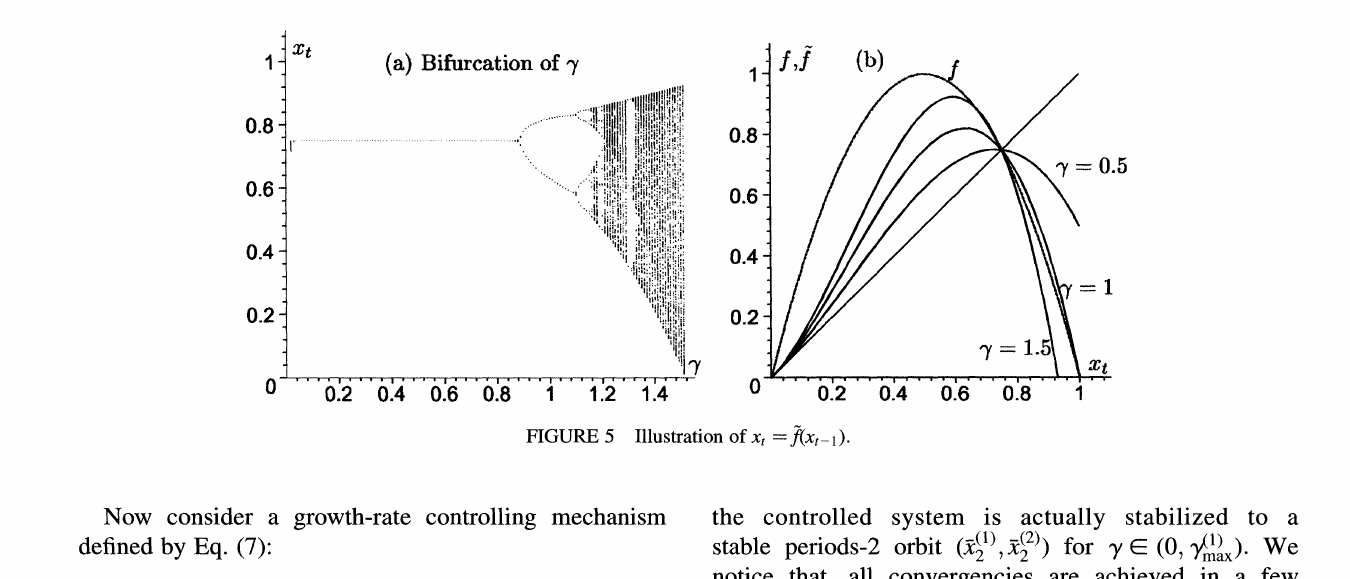
FIGURE 5 Illustration of xt ’(xt- ).